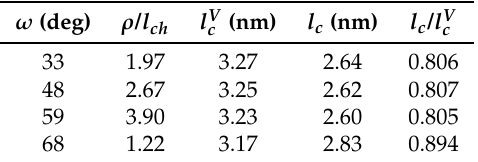
Table 3. Critical crack advancement for the geometries under consideration. The reference crack advancement related to a sharp notch provided by Equation (12) is also reported. Irwin’s length is equal to l ch = ( K Ic / σ u ) 2 ≈ 5.18